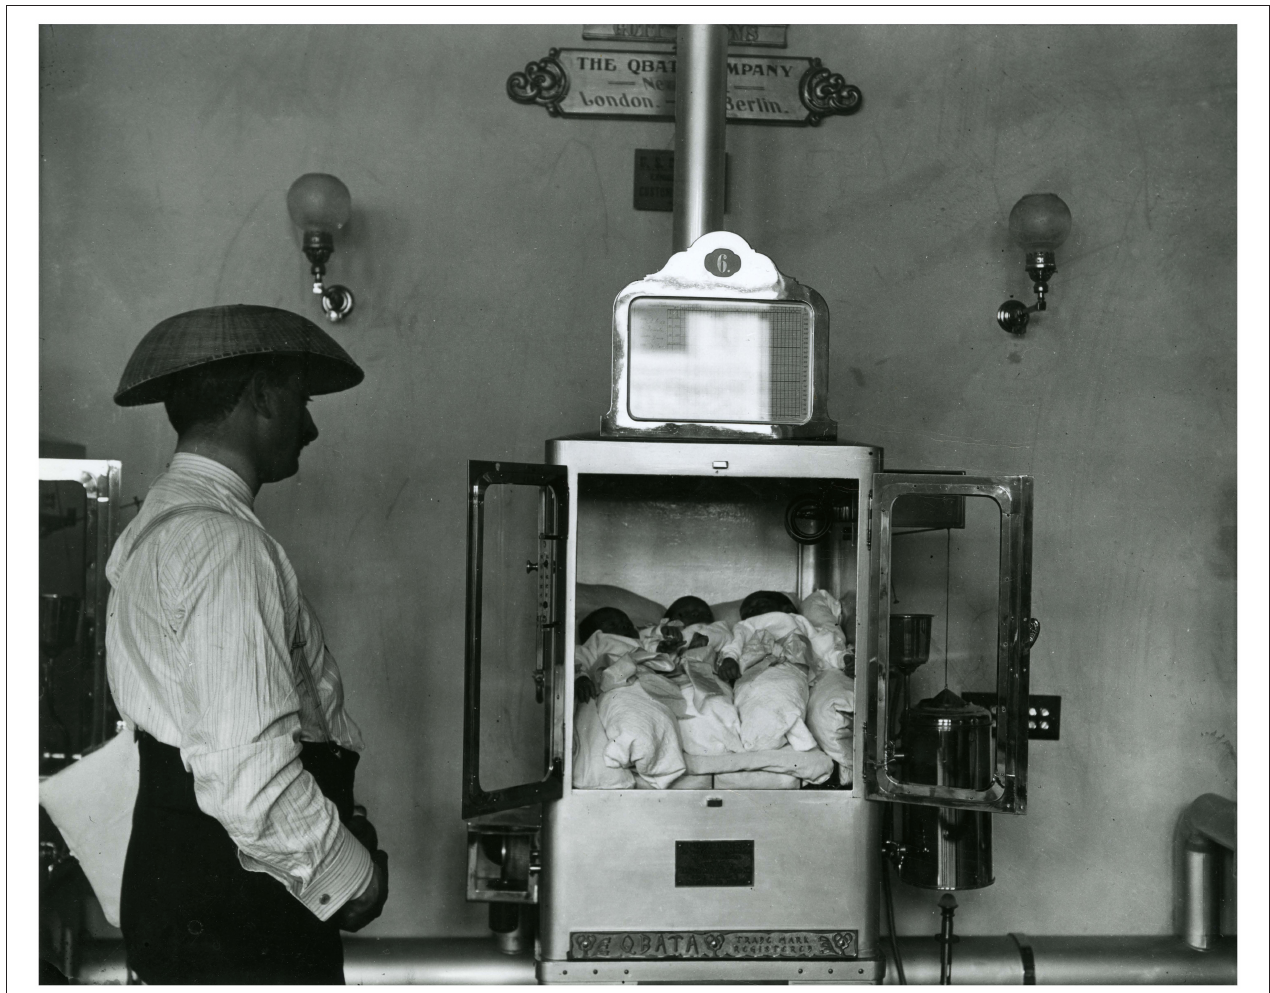
FIGURE 3 | History of Medicine: The Incubator Babies of Coney Island. Retrieved from: https://columbiasurgery.org/news/2015/08/06/history-medicine-incubator- babies-coney-island.